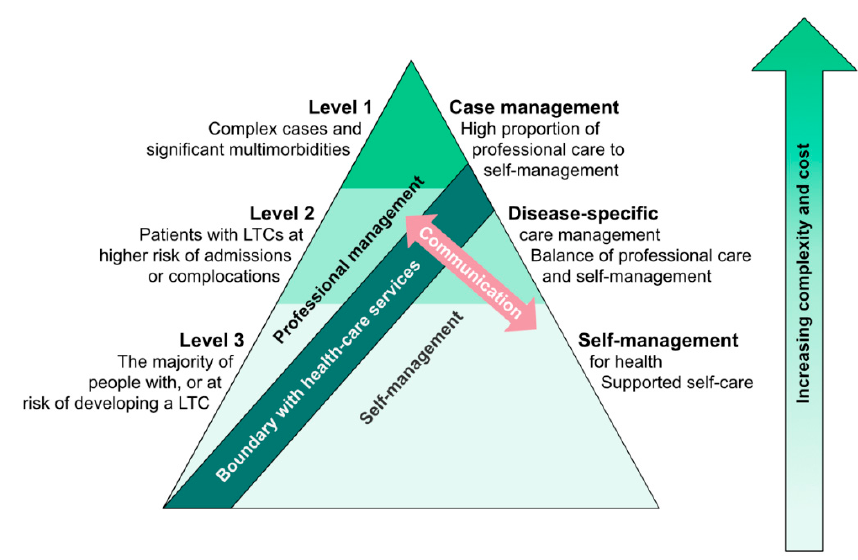
Figure 2. “Kaiser pyramid” about the interaction between patient disease-related self-management and professional management. In chronic diseases with little complexity in disease burden and / or therapeutic needs (level 3), self-management by persons with chronic conditions (PwCDs) is the major contributor to overall management, relative to the minor contribution of professional disease management. The more complex the disease and related therapeutic needs become (levels 2 and 1), the smaller becomes the relative contribution of self-management in comparison to professional management. The higher the relevance of professional management becomes, the more important becomes professional management support, e.g., by structured case management. Adopted from [8].